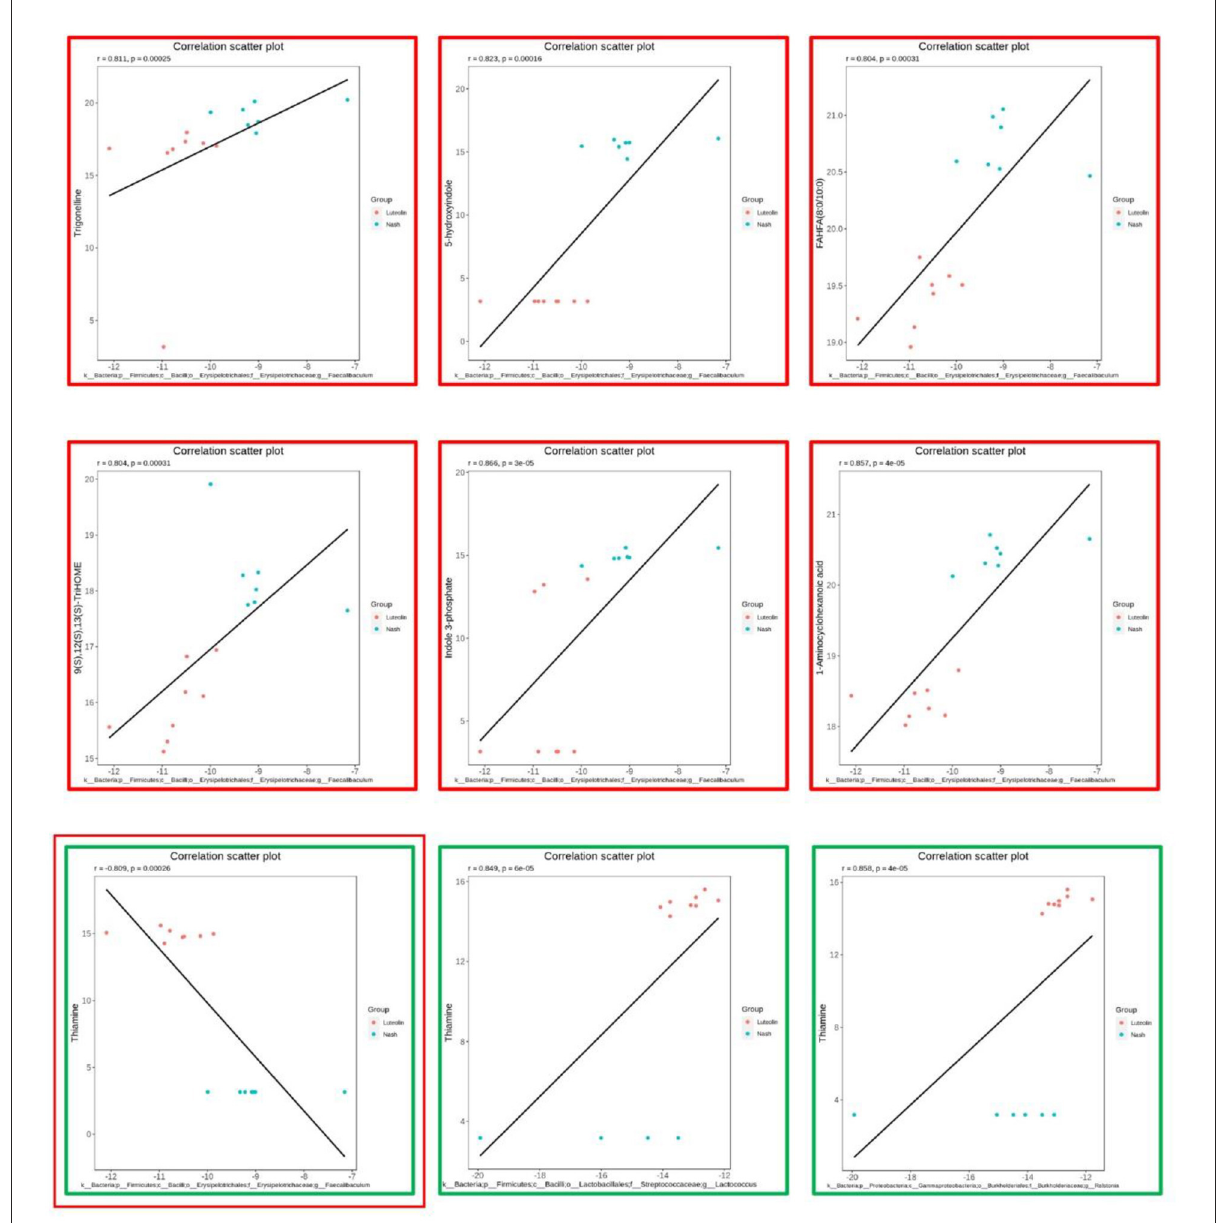
FIGURE8 The most significantly correlated microbes and metabolites ( n = 6–8 per group).